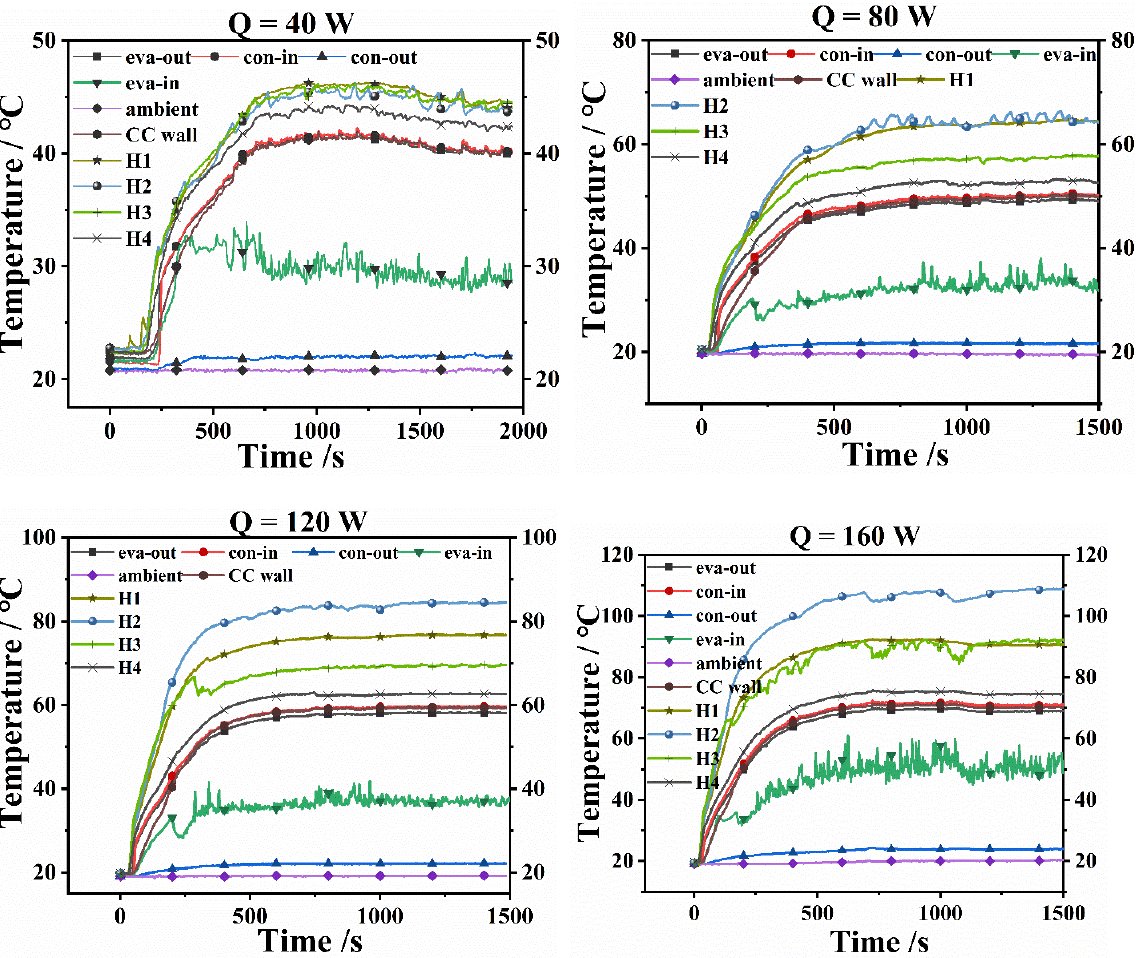
Figure 12. Temperature response during start up process of No.5 position at 40 W, 80 W, 120 W and 160 W.